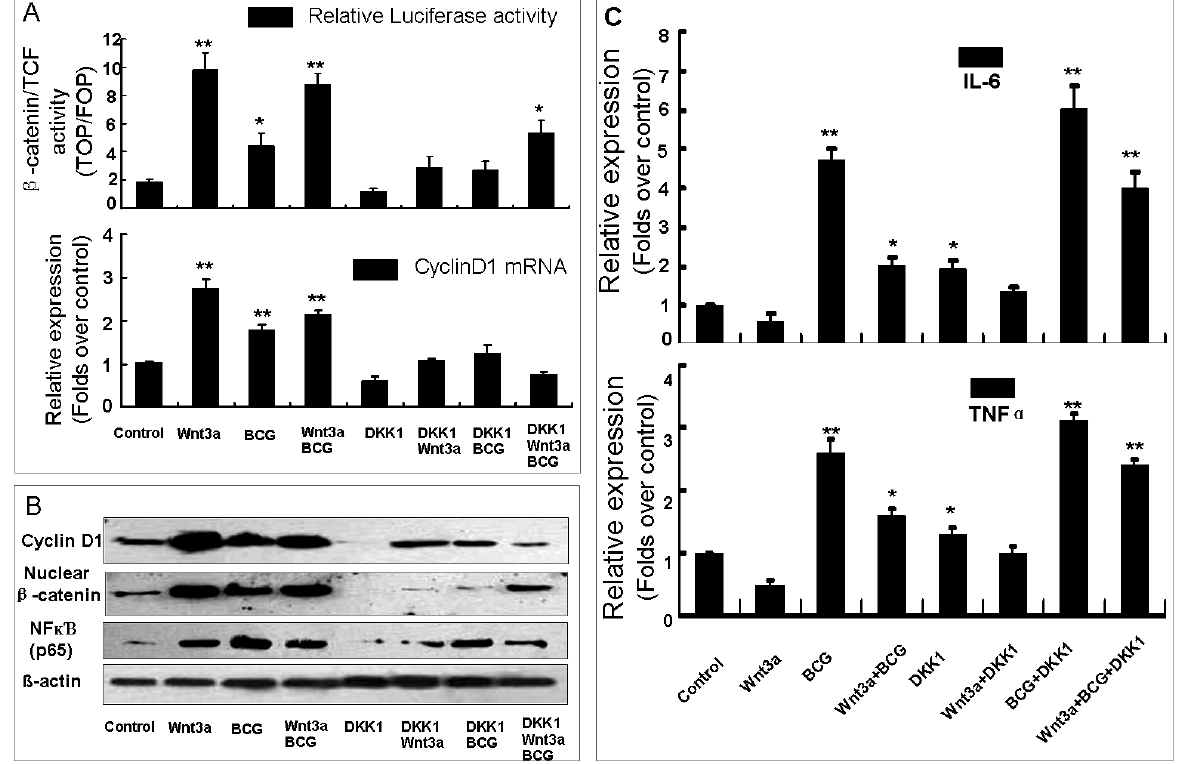
Figure 1. The impacts of Wnt/ β -catenin signaling in RAW264.7 cells in response to BCG infection. ( A ) The impact of BCG infection on macrophages was first ascertained by evaluating the relative firefly luciferase activity and the expression of Wnt target gene Cyclin D1 in RAW264.4 cells that transfected with β -catenin/TCF reporter TOPflash and treated with indicated conditions. In the absent of BCG stimulation, RAW264.7 cells showed a weak baseline Wnt signaling activity. However, the Wnt signaling activity could be dramatically elevated by Wnt3a and the BCG infection, and repressed by a Wnt signaling inhibitor, DKK1; ( B ) Immunoblots showed the expressions of Wnt target gene Cyclin D1, nuclear β -catenin and. P65 subunit of NF κ B; ( C ) An ELISA analysis of the supernatants of RAW264.7 cells treated with indicated conditions showed the impacts of Wnt3a signaling on the productions of IL-6 and TNF- α in macrophages. Compared to a naïve control, * p < 0.05; ** p < 0.01. Data represented the mean ± SD from three independent triplicated experiments ( n =